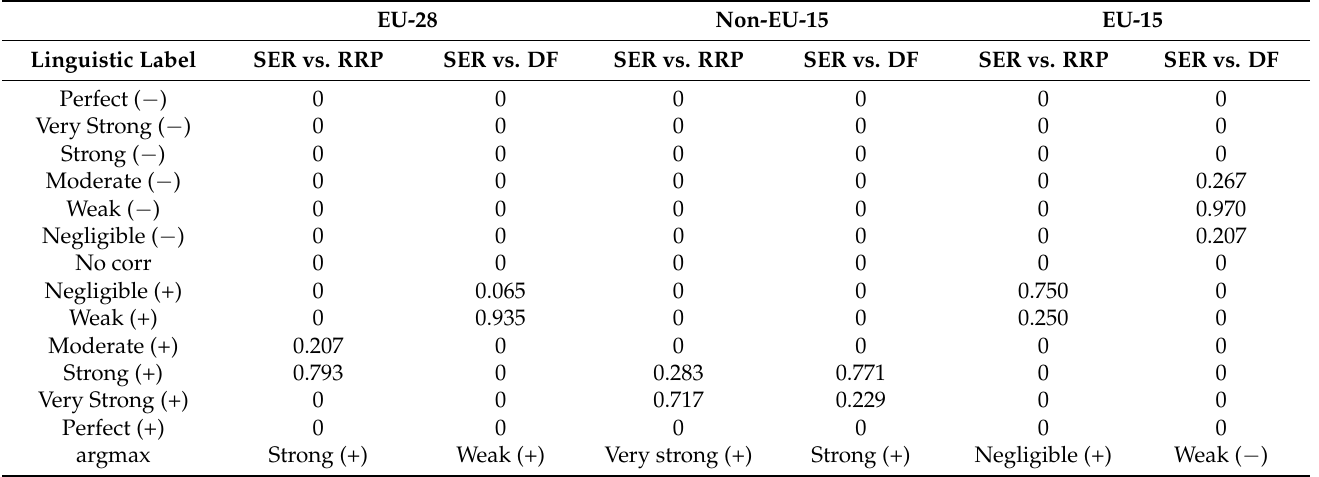
Table 12. Value of the compatibility indexes (7b) of the correlations between SER with RRP and DF and the labels of linguistic variable “correlation